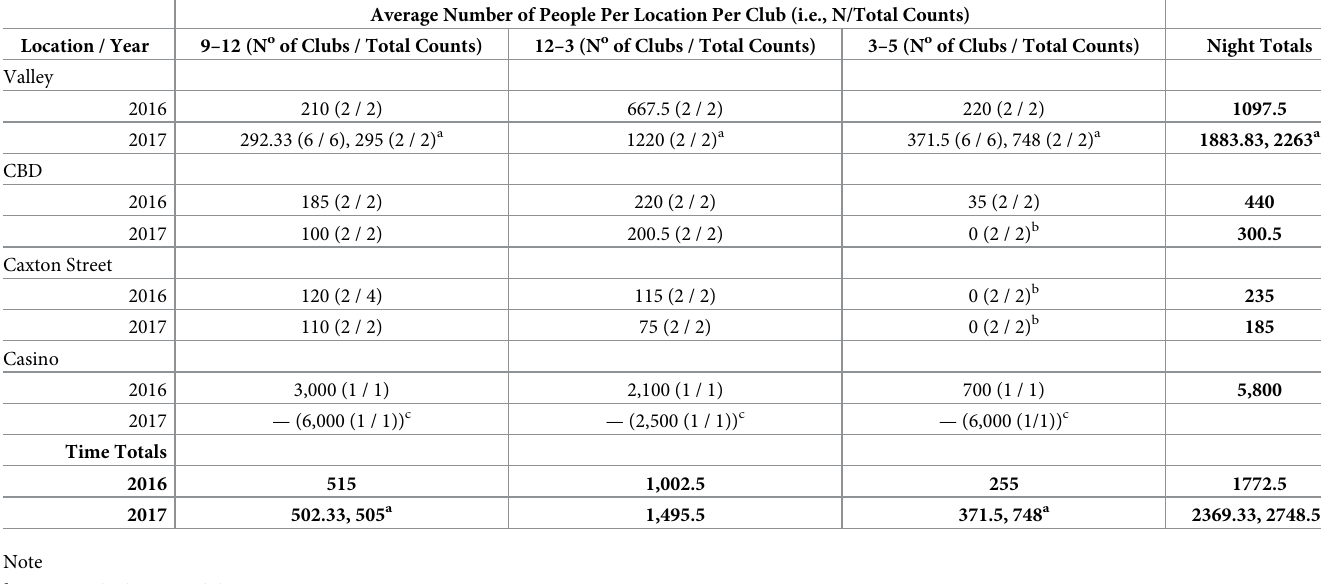
Table 5. Big night out club